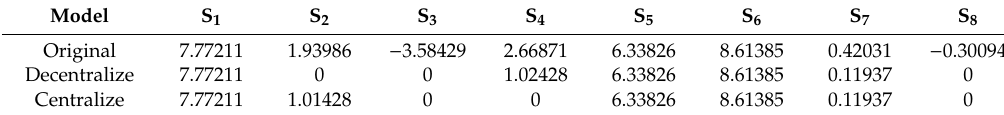
Table 2. Four groups of different locomotive power data in eight supply power sections (MW).